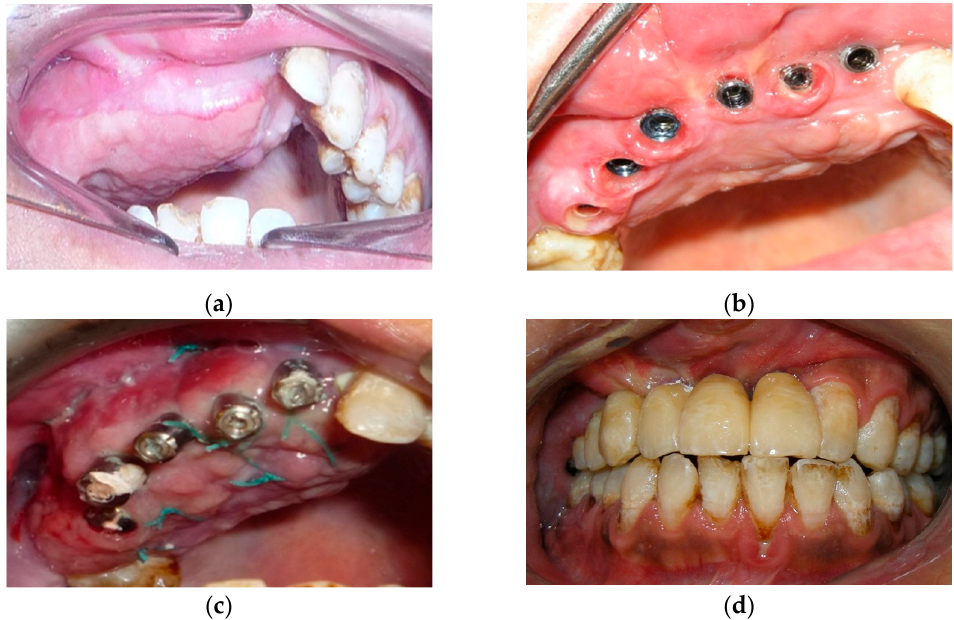
Figure 6. Intraoral view: ( a ) before treatment; ( b ) dental implant placed; ( c ) dental implant placed after a fornix depth; ( d ) final implant supported prosthetic rehabilitation.